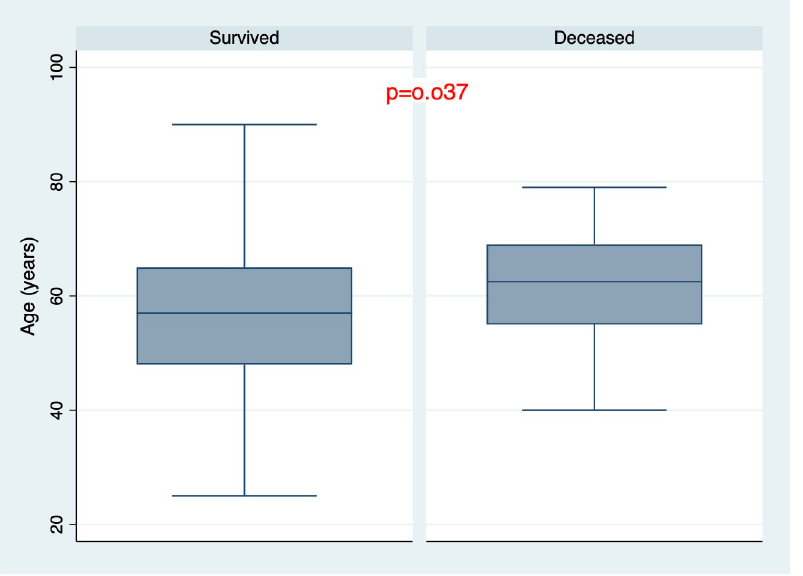
Fig 1. Age distribution among survived and deceased patients.